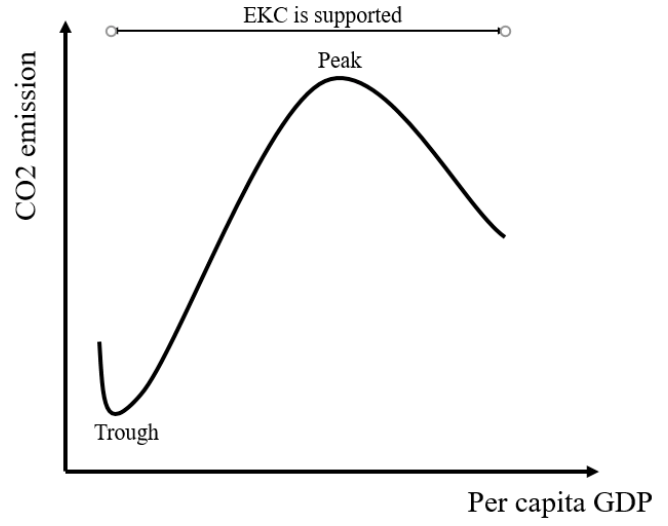
Figure 3. Schematic representation of income and CO 2 emissions.